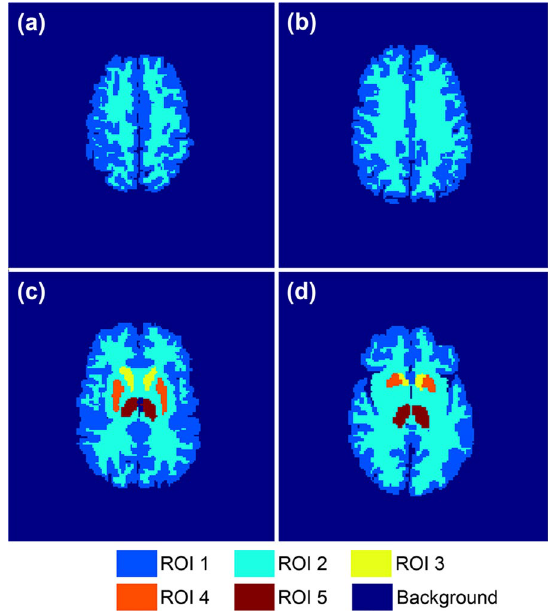
Fig. 2 The Zubal phantoms used in simulation experiments. a b , c , and d are representative phantoms corresponding to differenct slices of the original 3D